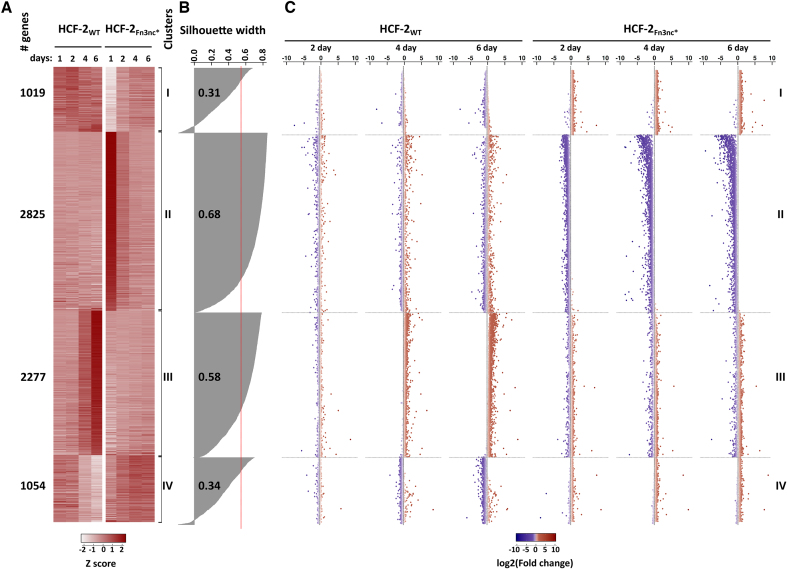
Induced HCF-2 synthesis leads to up-regulation of development-associated genes and down-regulation of metabolic genes. (A) Normalized counts of 7175 differentially expressed genes (see text, and ‘Materials and Methods’ section) were used to group genes into four clusters (I–IV, right) by expression profiles with PAM algorithm. The scaled and centered mean of the two replicates of each timepoint/condition is shown in the heat-map, with relative abundance of transcript per gene (Z-score) color-coded as shown in color scale. Left, number of genes per cluster. (B) Silhouette widths of each PAM-generated gene cluster. Red line, average for all clusters Silhouette width; fractional numbers, average Silhouette width for each individual cluster. (C) Scatter plot of log2 (Fold change) of transcript abundance at days 2, 4 and 6 with respect to day 1. Genes are shown in the same order as in the heat-map.